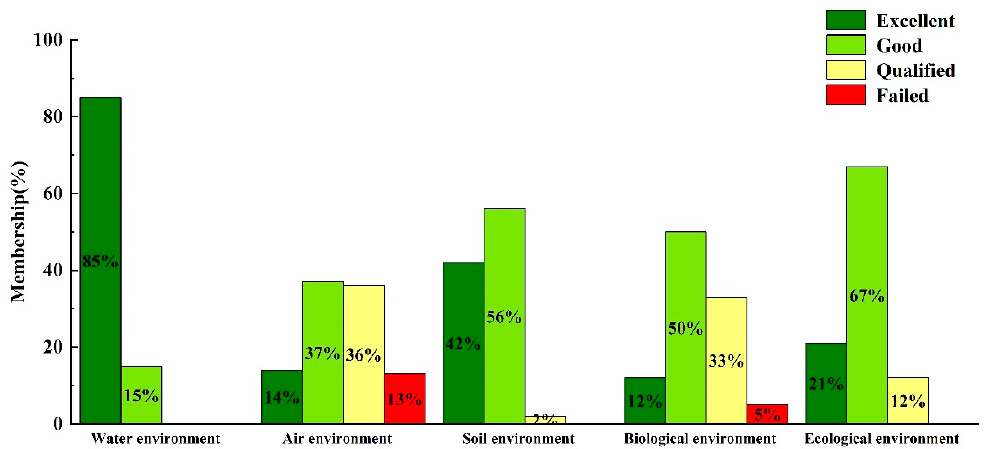
Figure 6. Dimension layer and evaluation results for the ecological environment in the Songshan Nature Reserve.